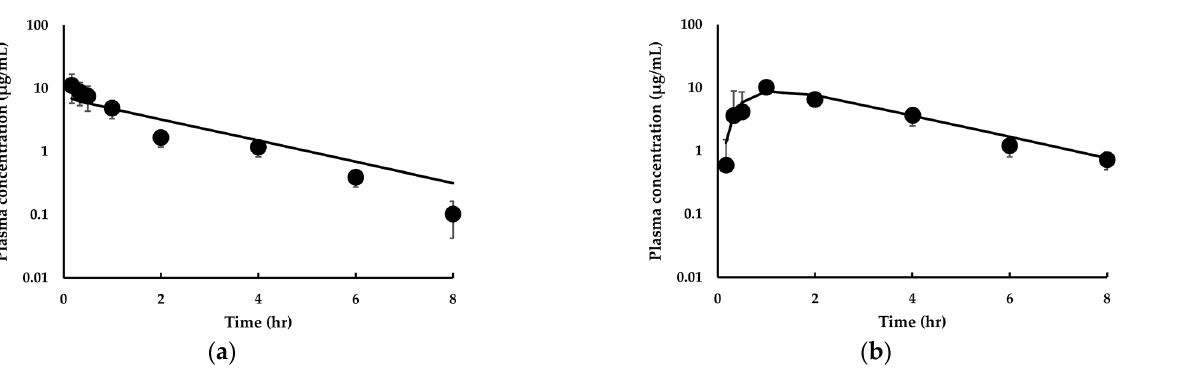
Figure 5. Observed and predicted time–concentration profiles for IDP-73152 following ( a ) 10 mg/kg intravenous and ( b ) 20 mg/kg oral administration in dogs. Solid lines represent predicted data. Closed circles (•) represent observed data. Observed data are means ± SD ( n = 3 dogs). Table 5 . Observed and predicted PK parameters of IDP-73152 in dogs.